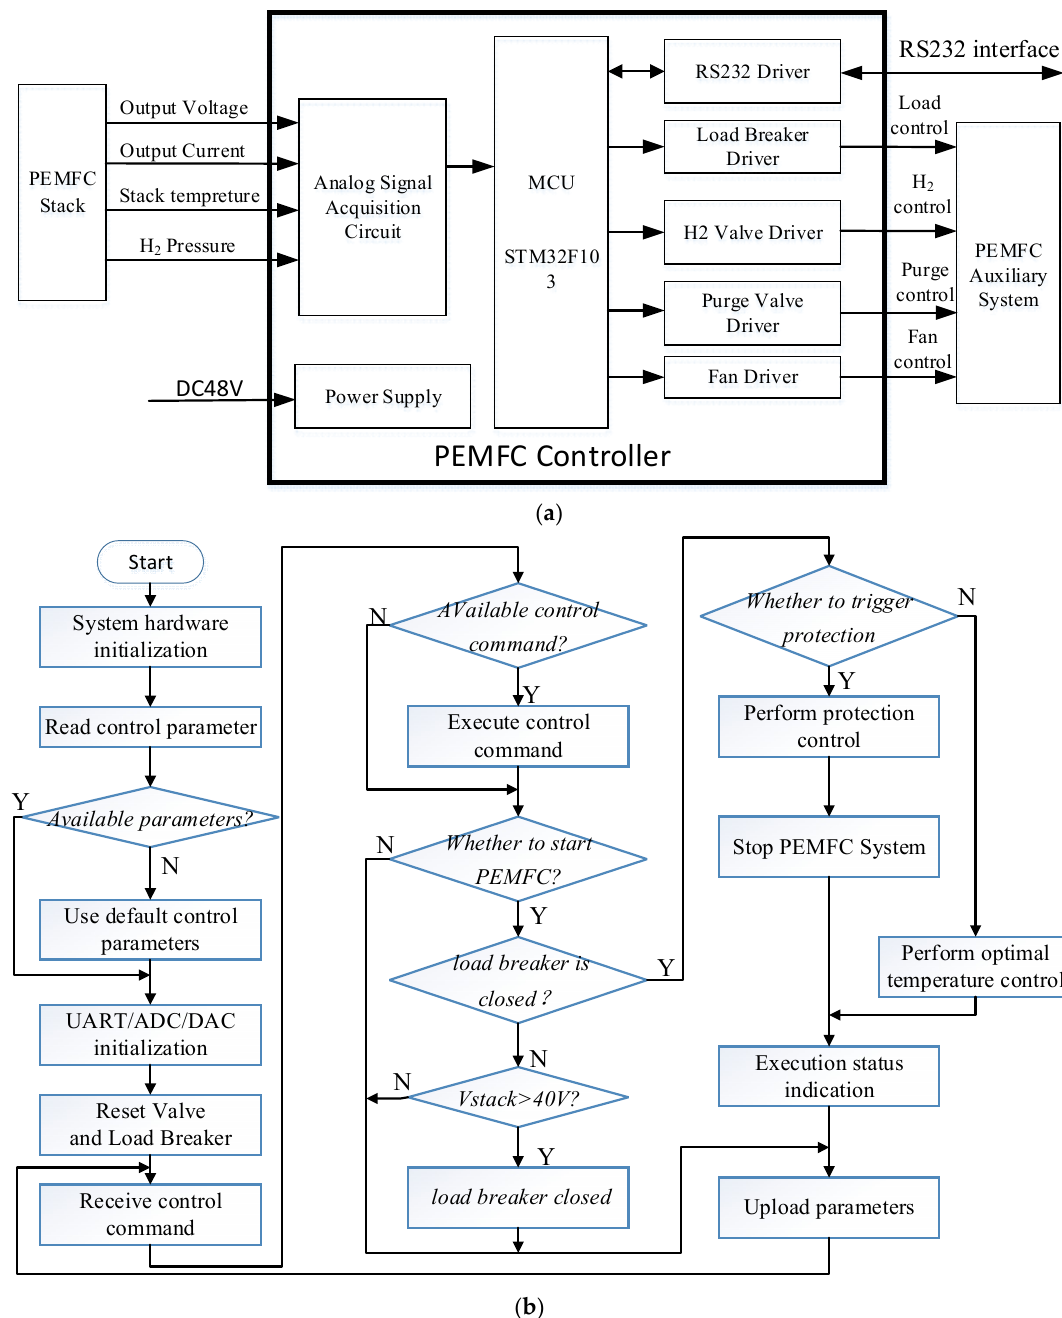
Figure 5. Functional diagram and control flowchart of the PEMFC controller. ( a ) Functional diagram of the PEMFC controller; ( b ) Control flowchart of the PEMFC controller.